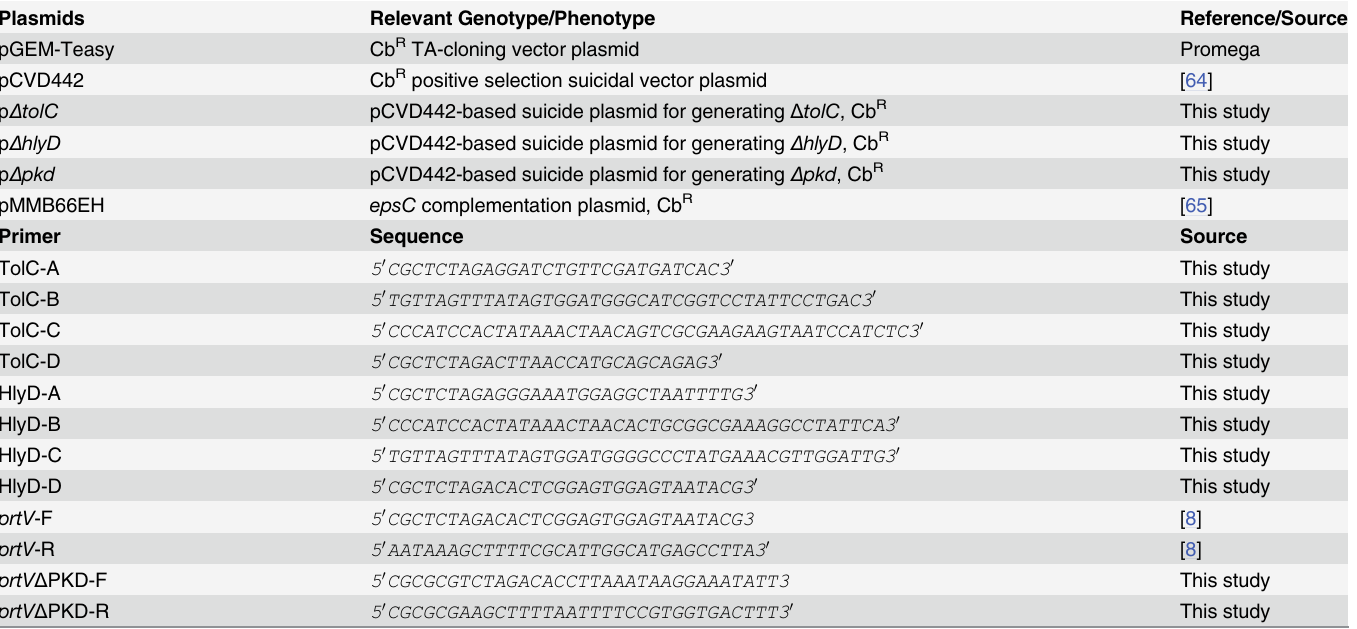
Table 2. Plasmids and primers used in this